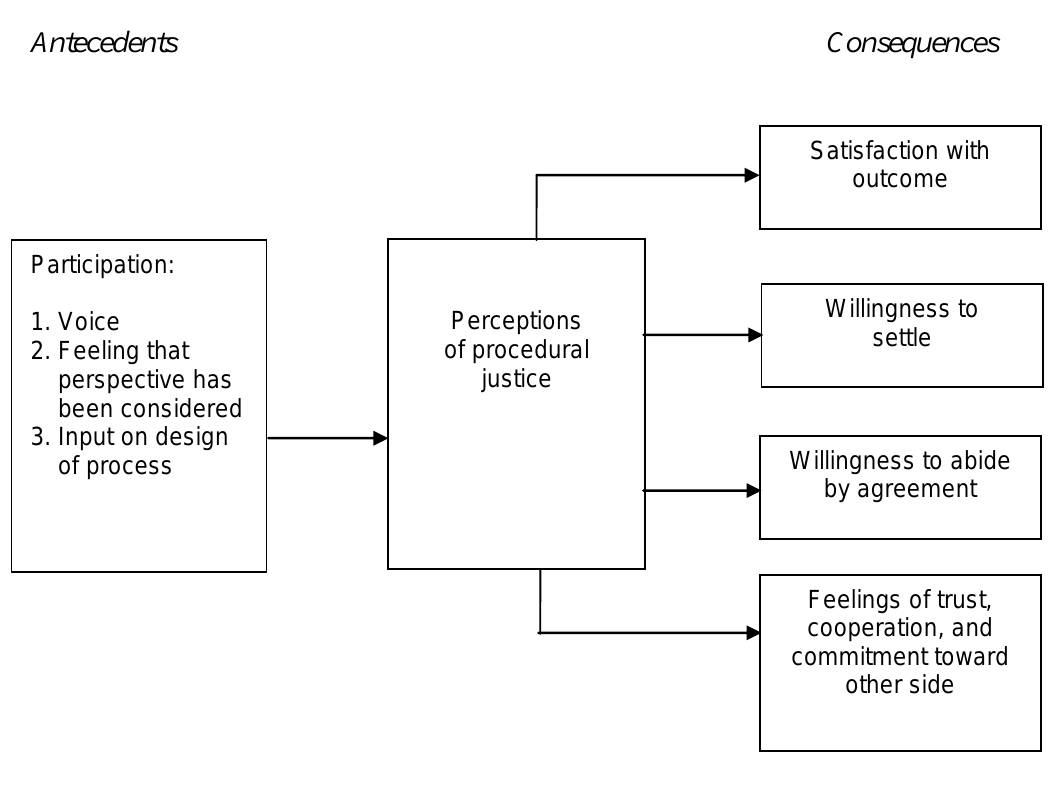
Figure 1 Antecedents and consequences of procedural justice Source: Allred (2005: